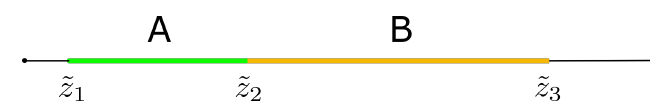
Figure 18. Configuration involving two adjacent intervals away from the boundary in a BCFT 1+1